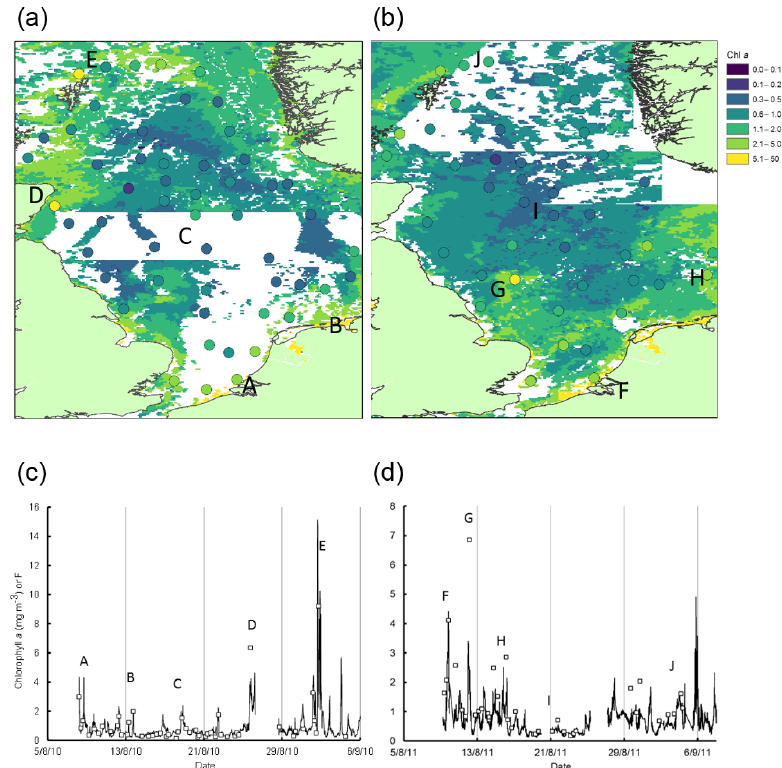
Figure 2. Maps of satellite-derived surface phytoplankton chlorophyll distribution during the summer IBTS cruises of (a) 2010 and (b) 2011, overlaid with the in situ observations in circles. White areas are where no satellite data were available. Time series of phytoplankton chloro- phyll along the IBTS cruise track in (c) 2010 and (d) 2011 as assessed by continuous measurements of chlorophyll fluorescence (solid black line), and sampling of surface water for quantification of Chl a (open squares). Specific events along the tracks are referenced with a